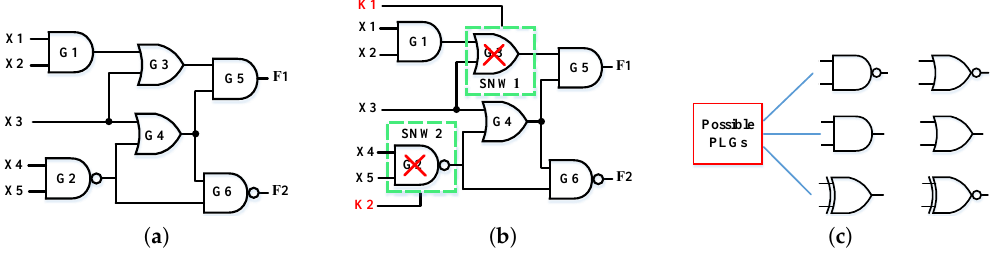
Figure 5. An example of encrypted a circuit using polymorphic logic gates designed using SiNW FETs ( a ) an original circuit ( b ) encrypted circuit via exchanging some gates in the original circuit with polymorphic logic gates, where both of AND/OR and NAND/NOR polymorphic gates are incorporated) ( c ) three possible polymorphic logic gates produce six different logic